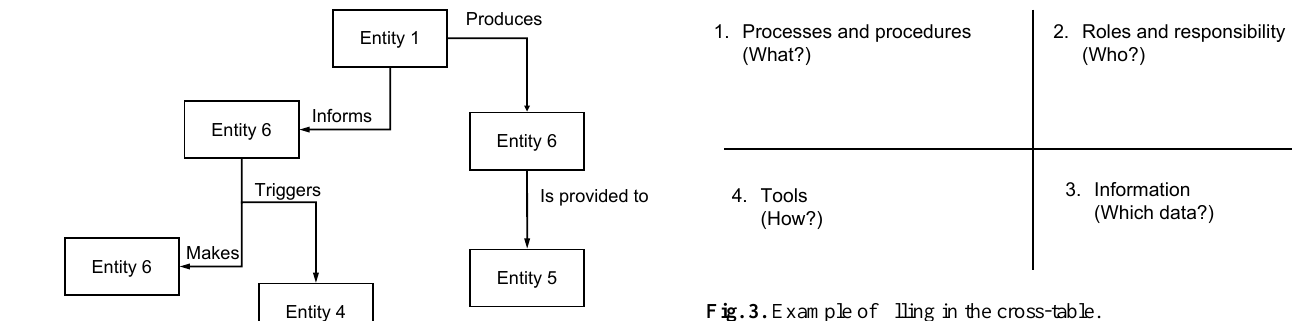
Fig. 3. Example of filling in the cross-table.